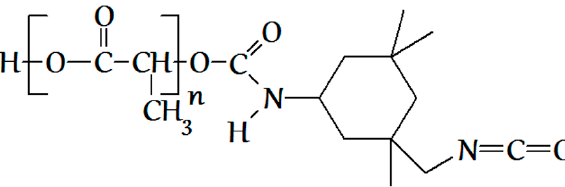
Figure 3. The structural formula of the isocyanate PLA derivative, obtained in the first stage.